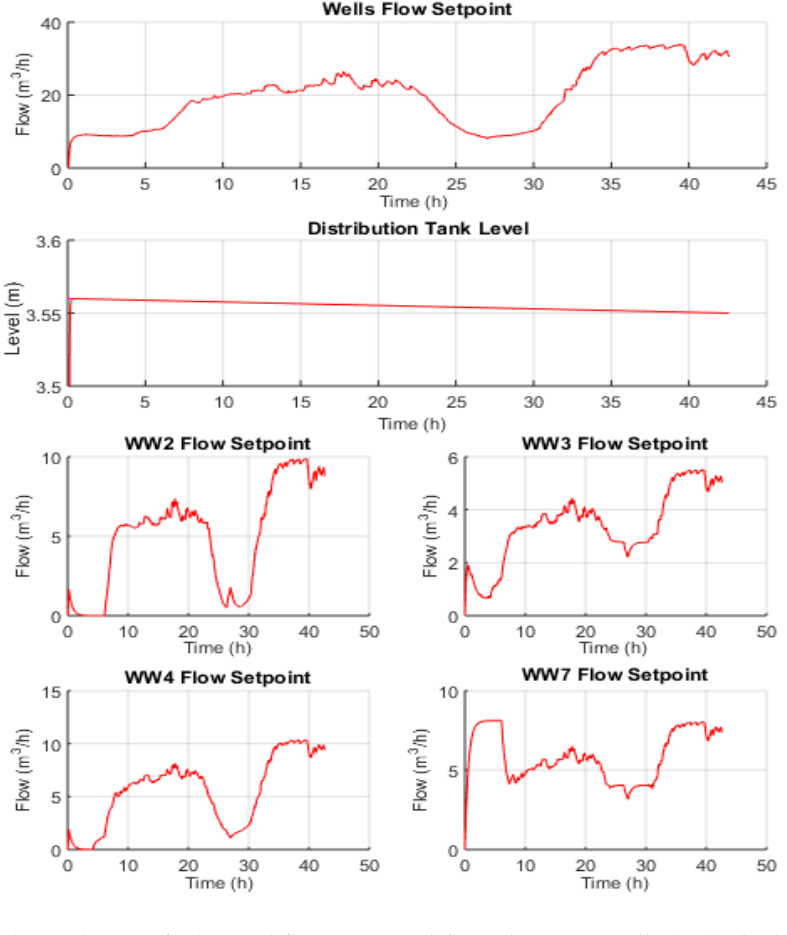
Figure 9. The evolution of: the total flow requested from the water wells ( F t_r ), the level in the distribution tank, and the flow setpoint for each water well ( F w_f ), resulting after FDC.